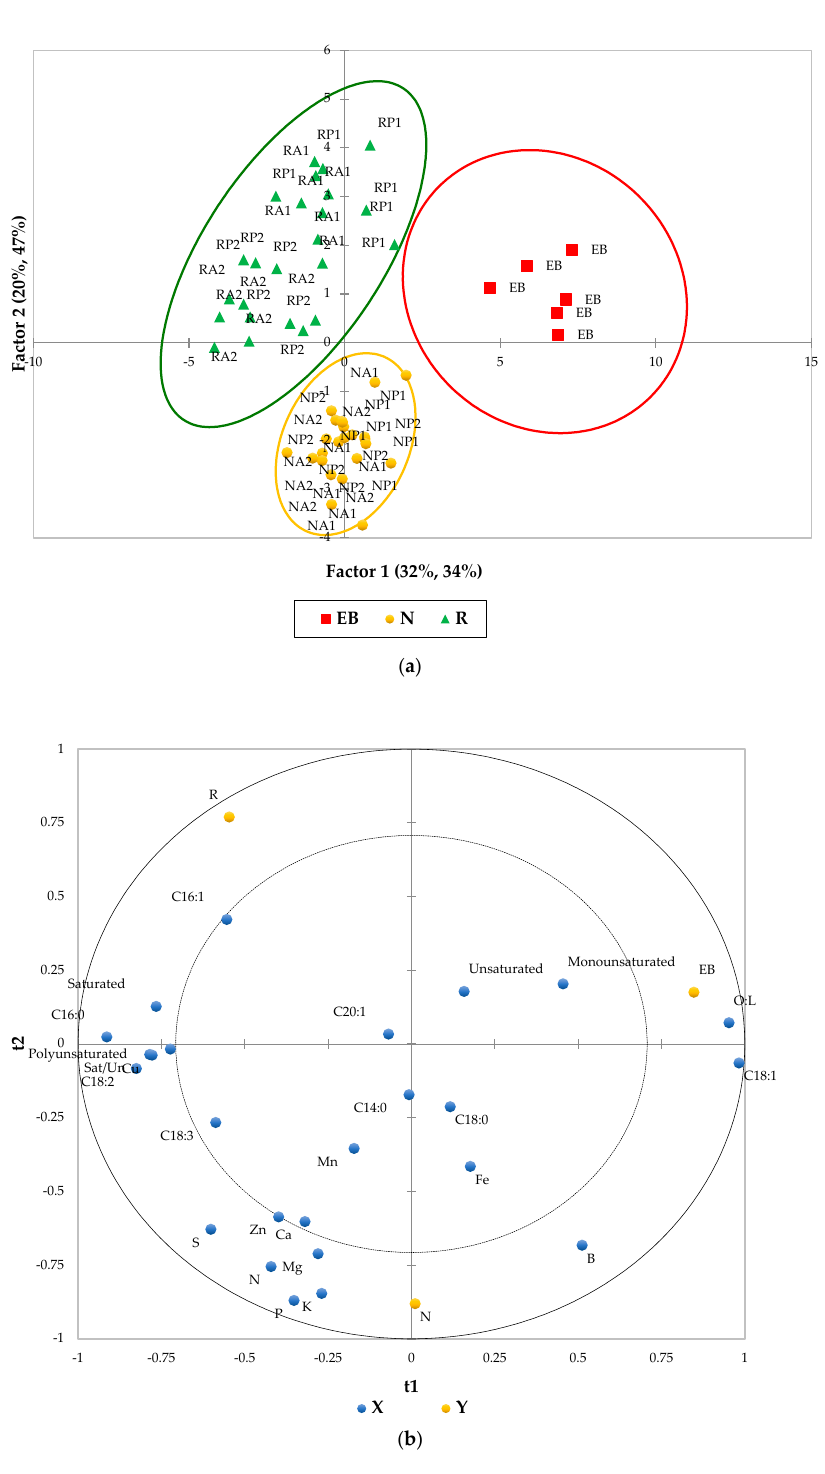
Figure 7. Partial least squares discriminant analysis (PLS-DA) results of the fatty acid and mineral contents grouped by orchard: Score plot ( a ); and loading plots ( b ). R 2 = 88.9 (3 factors). Orchards: EB, N, and R. A: Nutrient management based on the Balanced Indices of Kenworthy (BIK). P: Nutrient management of the farmer. 1. Harvest from the intermediate flowering period. 2. Harvest from the main flowering period. Sat/Un:(saturated and unsaturated relationship); C14:0 (myristic acid); C16:0 (palmitic acid), C16:1 (palmitoleic acid), C18:0 (stearic acid); C18:1 (oleic acid), C18:2 (linoleic acid), C18:3 (linolenic acid). C20:1 (arachidic acid), O:I (oleic and linoleic fatty acids